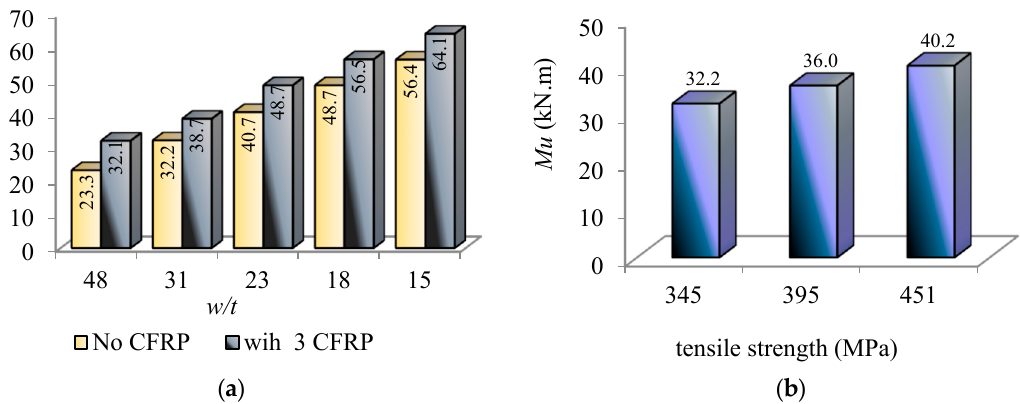
Figure 18. Mu values of the RCFSST models. ( a ) Varied w / t ratio and ( b ) varied tube’s tensile strength.